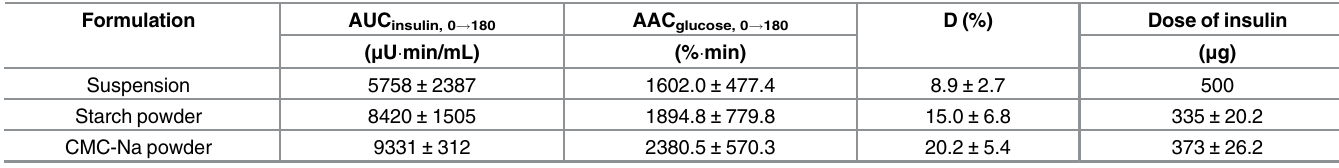
Table 1. Pharmacokinetic parameters of insulin and glucose in the plasma after nasal administration of suspension, starch powder, and CMC-Na powder. Formulation